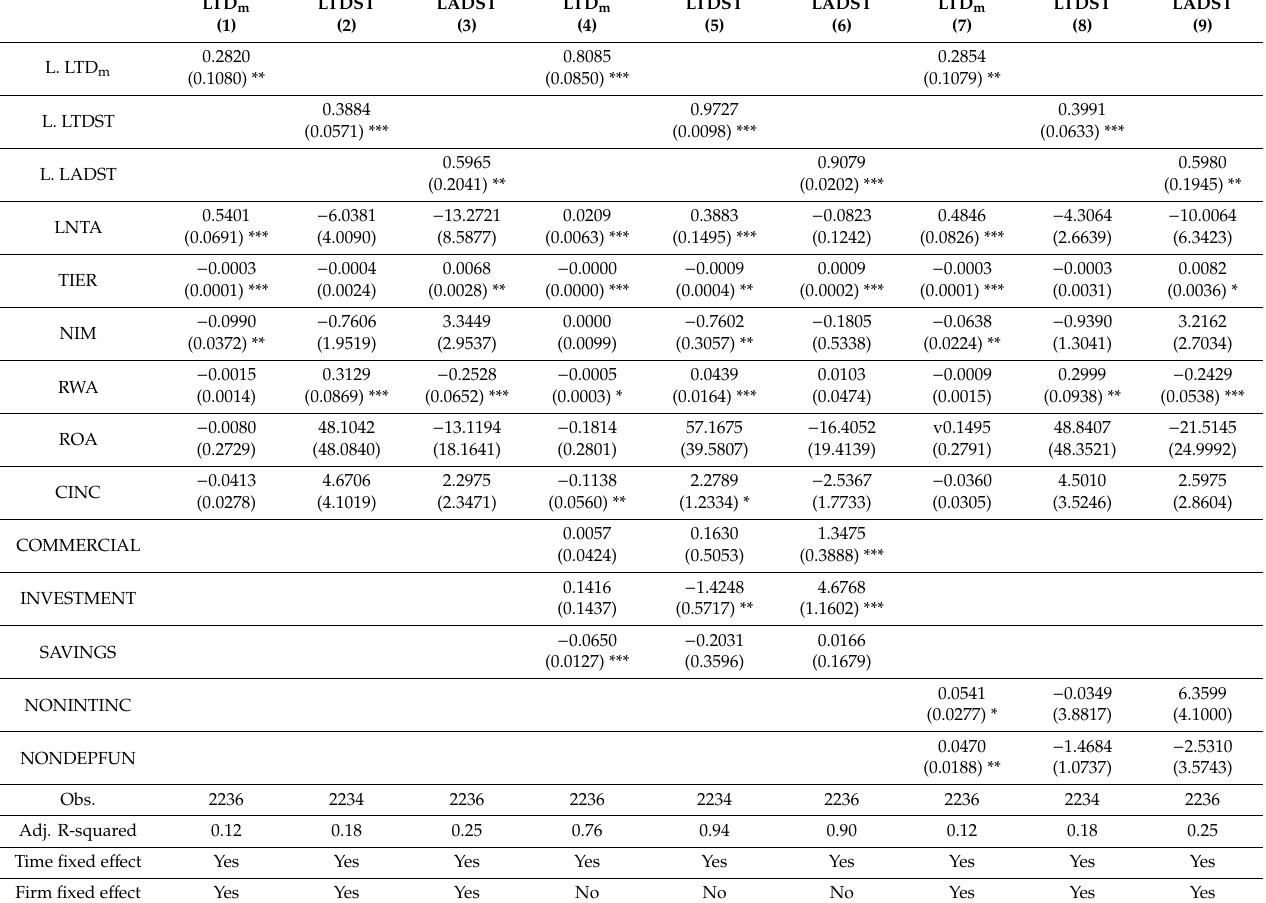
Table 3. Dynamic panel data